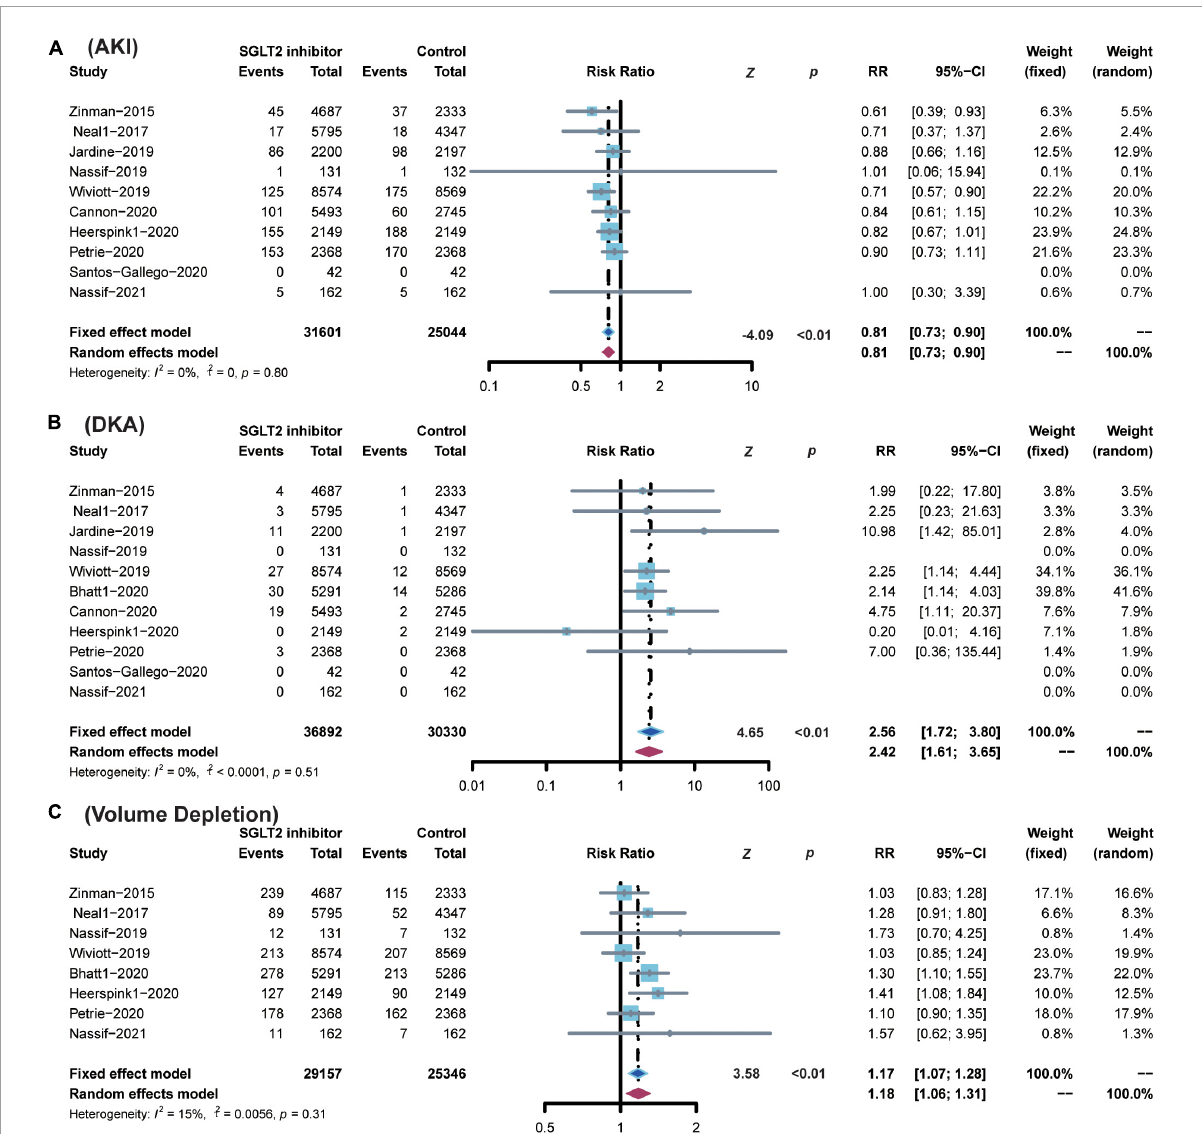
FIGURE6 Comparison of SGLT2 inhibitor vs. control group on the risks of (A) AKI; (B) DKA; (C) Volume Depletion. SGLT2, sodium-glucose cotransporter 2; AKI, acute kidney injury; DKA, diabetic